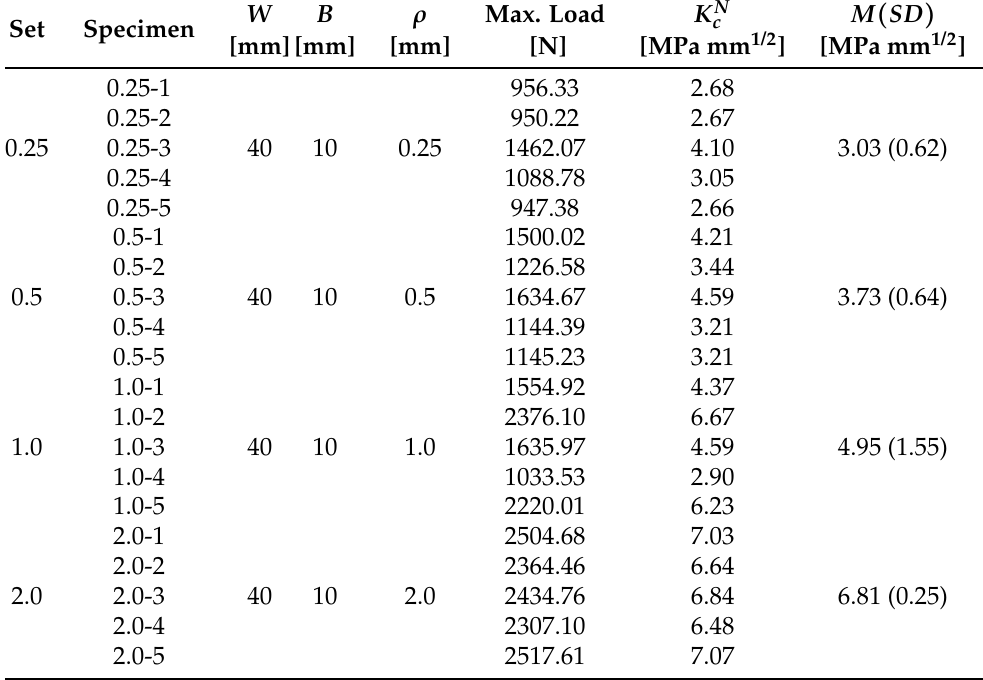
Table 2. Results from the experimental program on CT specimens of EPOLAM